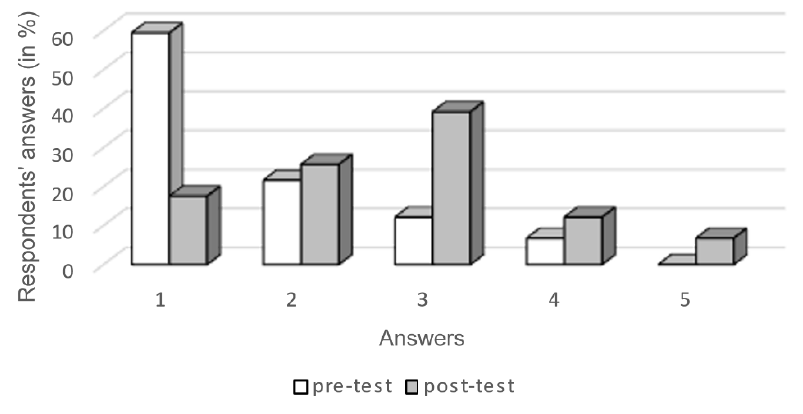
Figure 3. Respondents’ answers to question no. 10 (when learning algorithms, I consider it important to be able to use the whole algorithm in more complex tasks) in pre-test and post-test (in%).